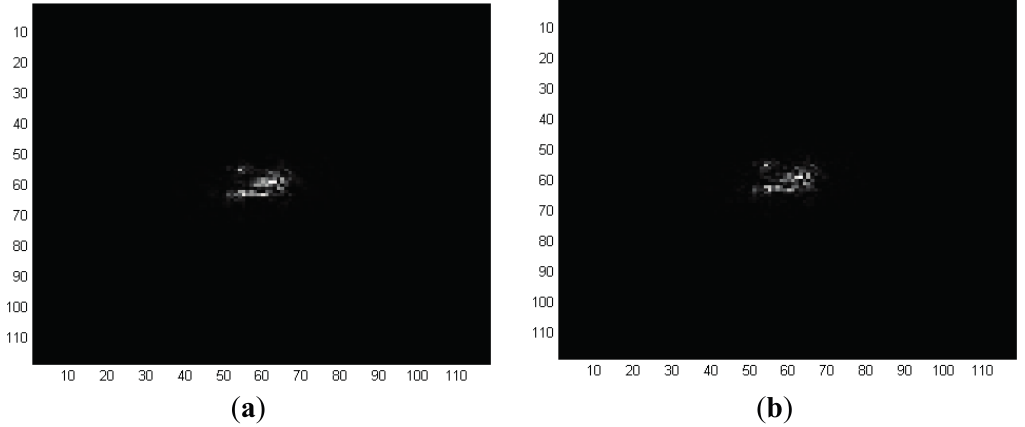
Figure 4. Spatial domain representation of Range-2 detection filters for the target (tank1) of Sequence L2018 ( a ) MACH filter; and ( b ) EMACH filter.